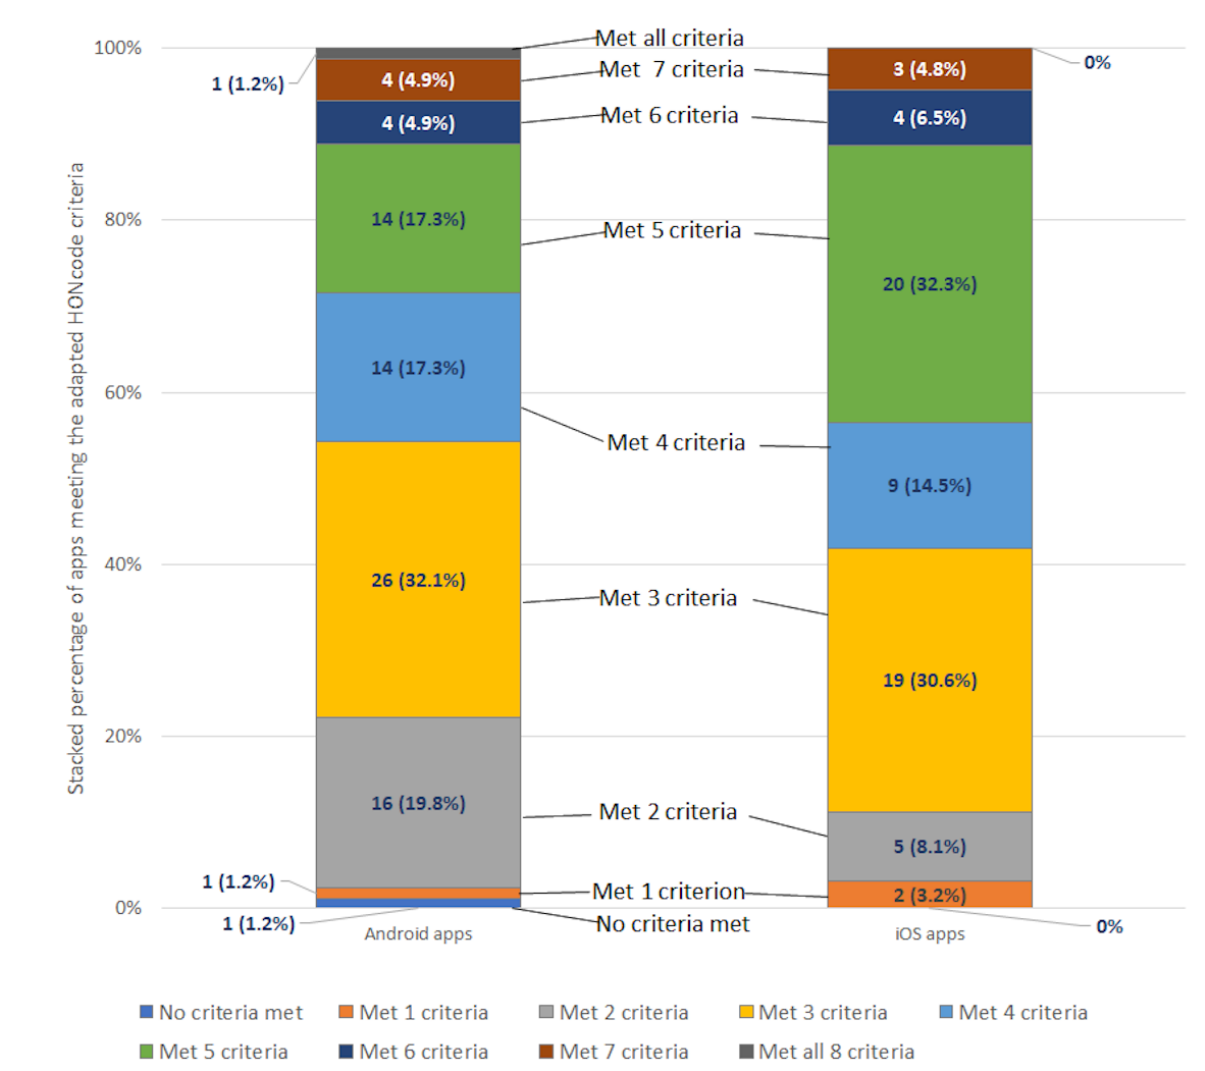
Figure 1. The number and proportion of diabetes apps meeting the App-HONcode app criteria. The number of Yes responses were summed up for each app to determine the number of app-HONcode criteria met. N/A responses for attribution and justifiability were treated as no, whereas the